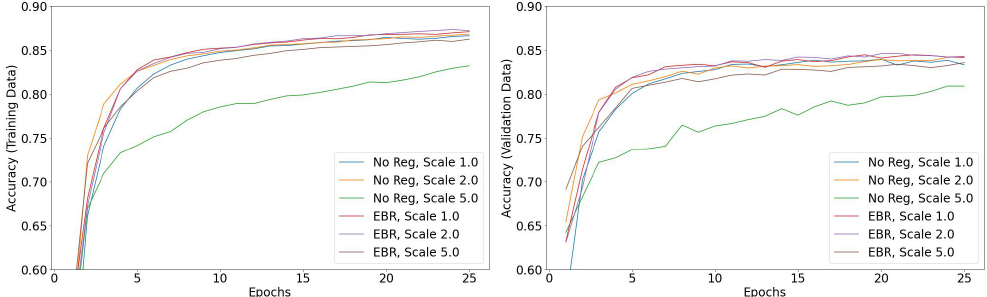
Figure 6. Comparison of accuracy for different variance scales of the initializer for layers with and without regularization ( left panel shows results for training data, right panel for validation